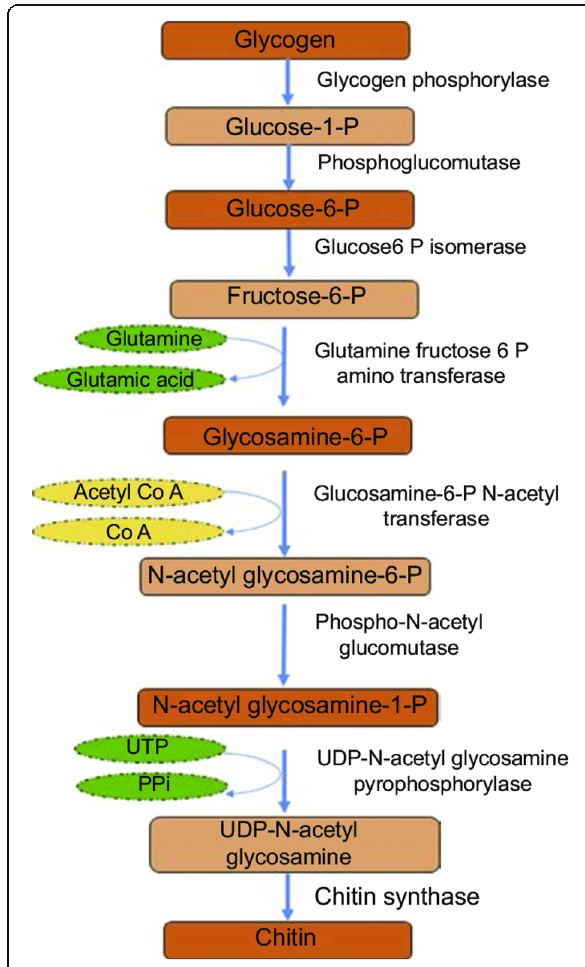
Fig. 3 Biosynthesis of chitin (Balaji et al.